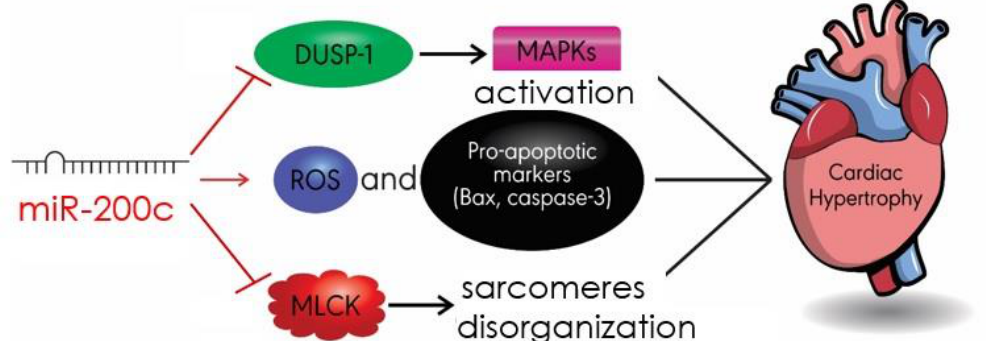
Figure 6. MiR-200c exhibits its pro-hypertrophic role by targeting a number of pathways. Mir-200c reduces the expression of DUSP-1, leading to the activation of MAPKs. MiR-200c targets MLCK and sarcomere organization. MiR-200c can also promote ROS production and enhance the expression of cardiomyocyte pro-apoptotic markers Bax and caspase-3. DUSP-1: dual-specific phosphatase-1; ROS: reactive oxygen species.